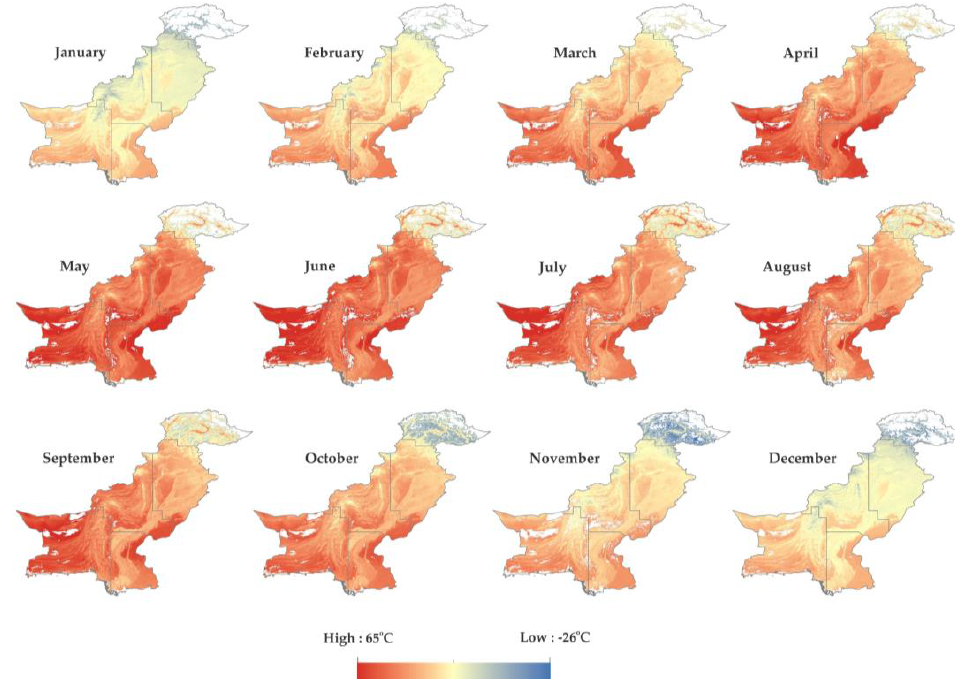
Figure 9. Spatial distribution of mean LSTs of 2018 and 2021 at monthly scales in Pakistan.